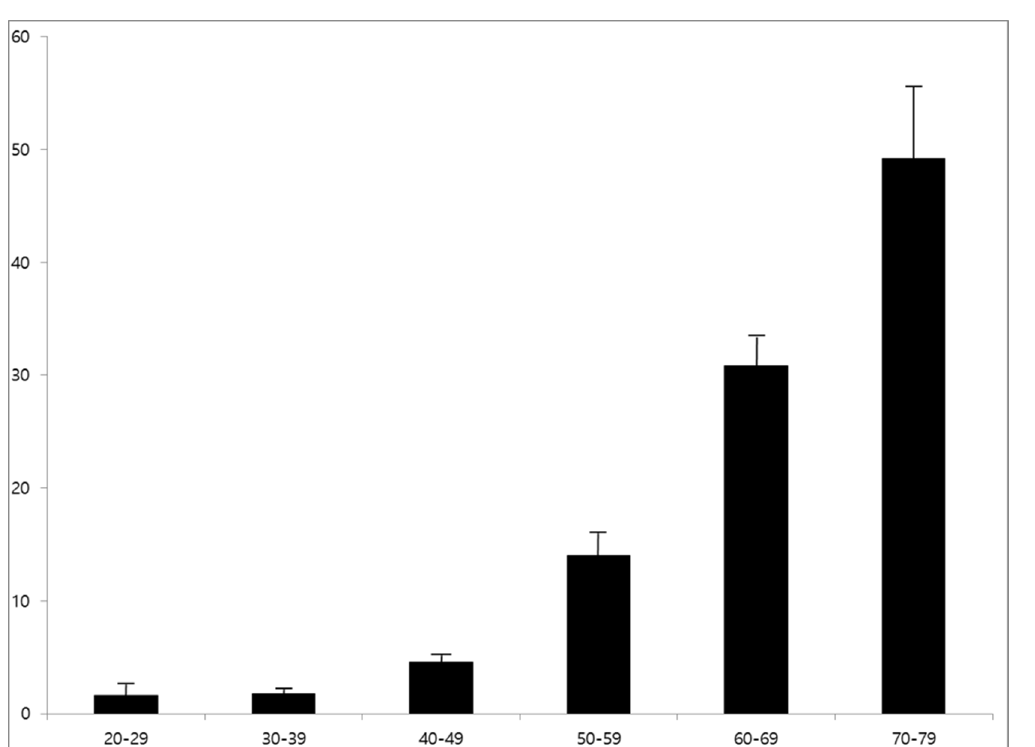
Fig. 1. Prevalence of hearing loss by age